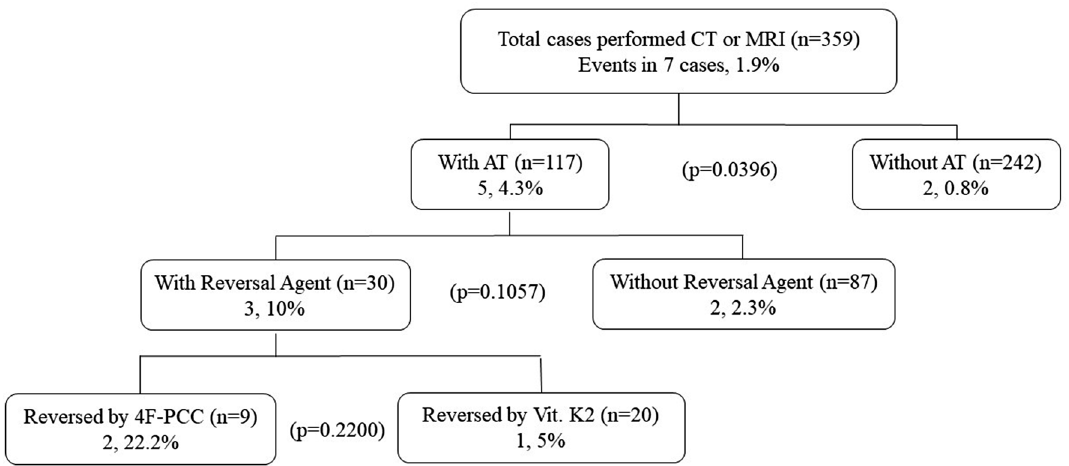
Figure 2. The incidence of ischemic stroke in patients with traumatic intracranial hemorrhage. There was significant difference in the incidence of ischemic stroke between AT users and AT non-users. And ischemic stroke tend to be occurred in reversal agent users, especially in 4F-PCC